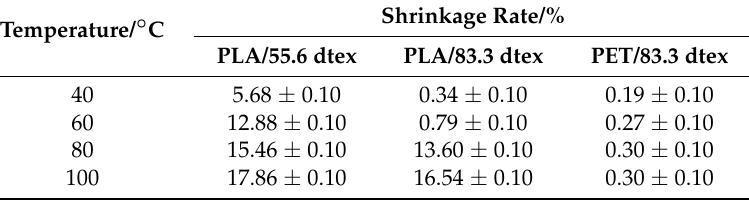
Table 4. Thermal shrinkage rates of three kinds of multifilament.